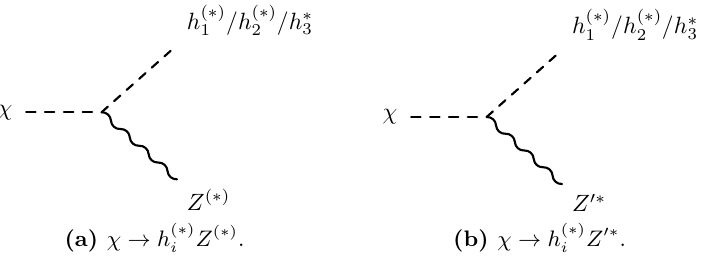
Figure 2. Feynman diagrams for χ decays into h ( ∗ ) Z ( ∗ ) (a) and h ( ∗ ) Z 0∗ (b), where h 1 , h 2 , and Z i i could be either on or off shell, while h and Z 0 must be off shell for m . 3 χ (cid:28) m h 3 , m Z 0 because of σ SI . Note that v = 10 5 GeV results in σ SI much smaller than the 90% ∝ v − 4 Φ χN χN Φ confidence level (C.L.) upper limits from the recent LZ direct detection experiment [5],